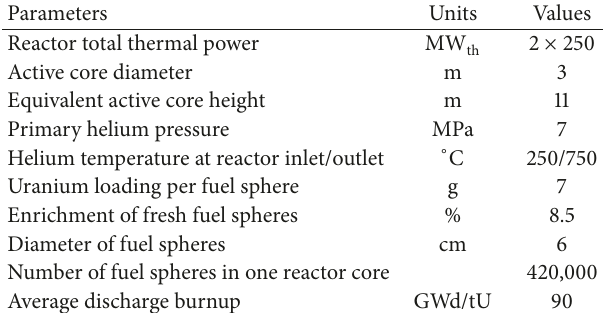
Table 1: Main design parameters of HTR-PM.